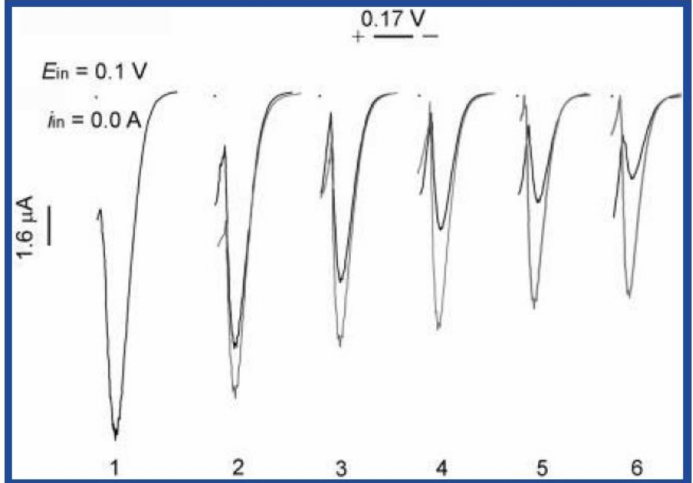
Figure 8. Anodic polarographic curves of H 2 O 2 before (1) and after addition of red ( dark line ) and white wine ( gray line ): (2) 100, (3) 200, (4) 300, (5) 400 and (6) 500 µ